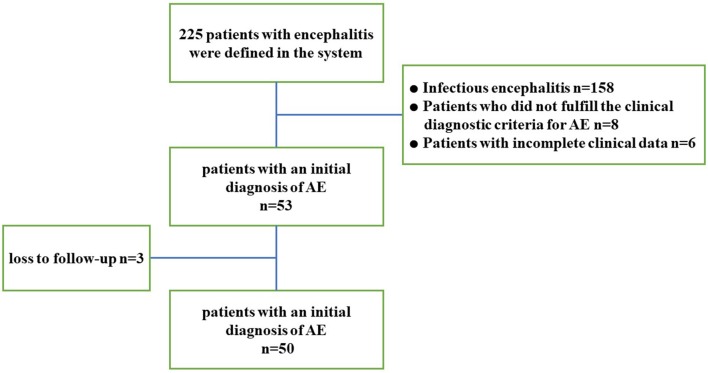
Study flowchart. AE, autoimmune encephalitis.